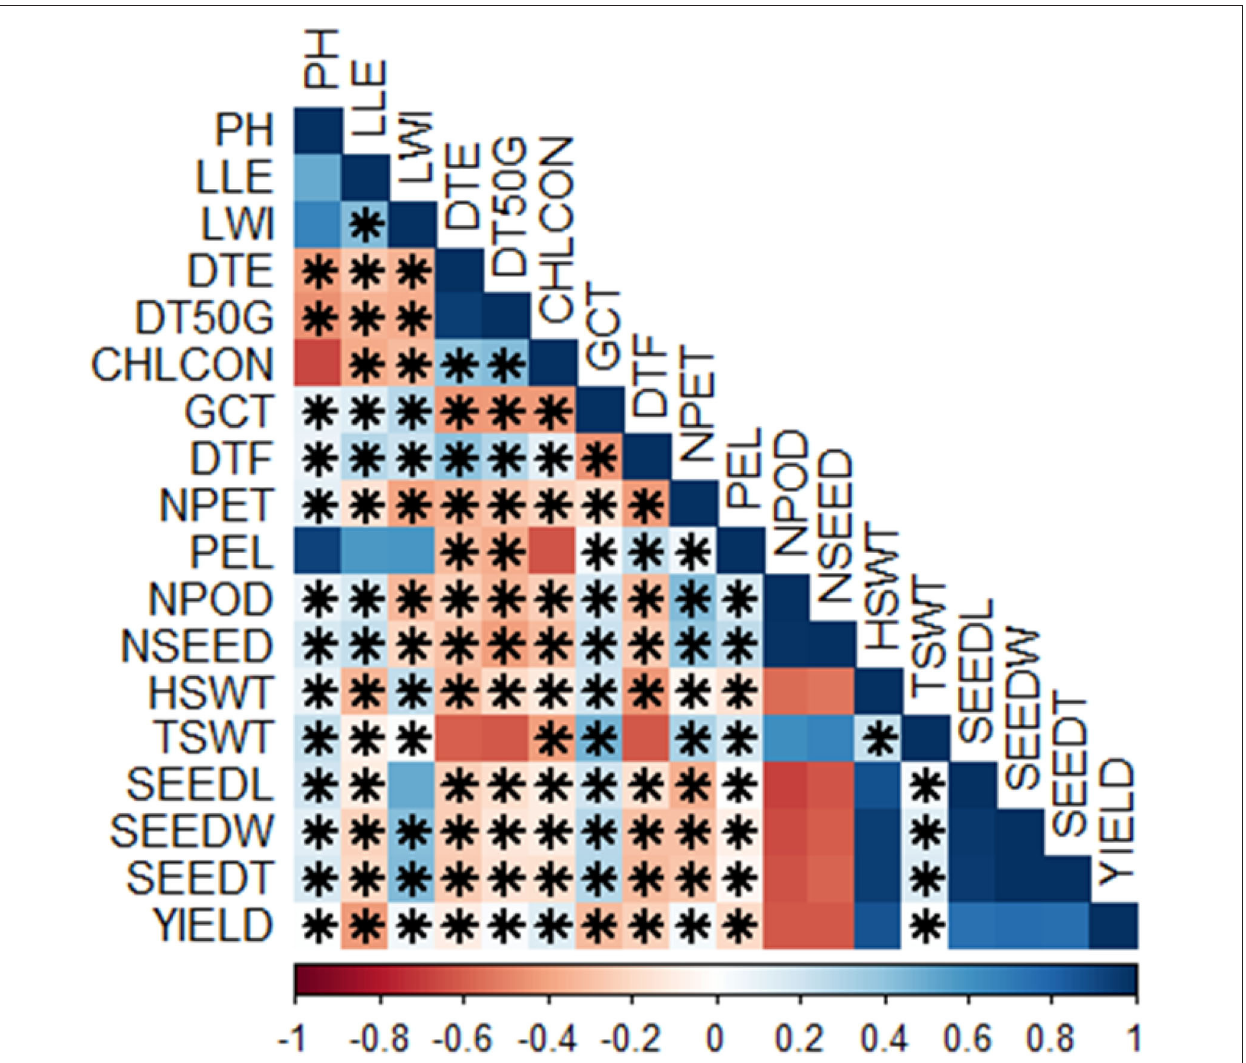
FIGURE 4 | Correlations among the traits scored; Pearson’s rank correlation matrix and performance analytic chart of the variables showing the relationship among the variables scored on BGN accessions grown across two locations and years. (Blue color indicates a significant positive correlation and red color indicates a significant negative correlation among different traits. PH, plant height (cm); LLE, leaf length (cm); LWI, leaf width (cm); DTE, days to emergence; DT50G, days to 50% germination; CHLCON, chlorophyll content; GCT, germination count; DTF, days to flowering; NPET, number of petioles; PEL, petiole length (cm); NPOD, number of pods; NSEED, number of seeds; HSWT, hundred seed weight (g); TSWT, total seed weight (g); SEEDL, seed length (cm); SEEDW, seed width (cm); SEEDT, seed thickness (cm), Yield (kg/ha). *Significant, p <